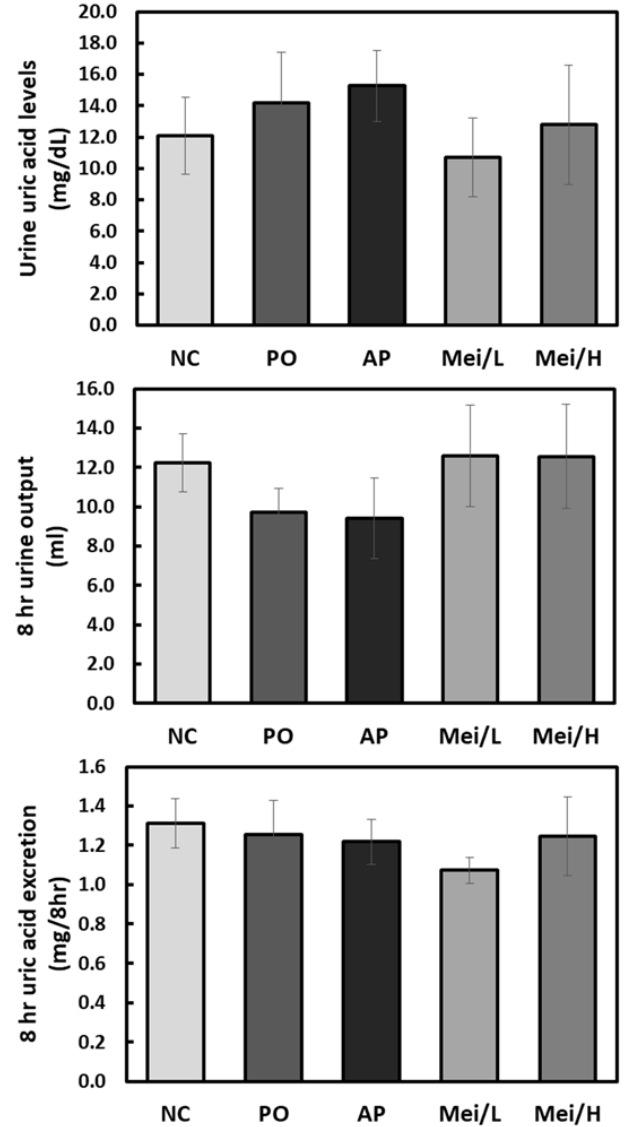
Figure 5. Effects of mei extract on urine uric acid, urine output, and 8-h uric acid excretion levels of potassium oxonate (PO)-induced hyperuricemic rats. NC designates the normal control group, and AP represents treatment with allopurinol. Mei/L and Mei/H represents treatment with low and high dosage of mei extract, respectively. Data are presented as mean ± SEM ( n = 5–6). No statistically significant difference is observed between any two groups.